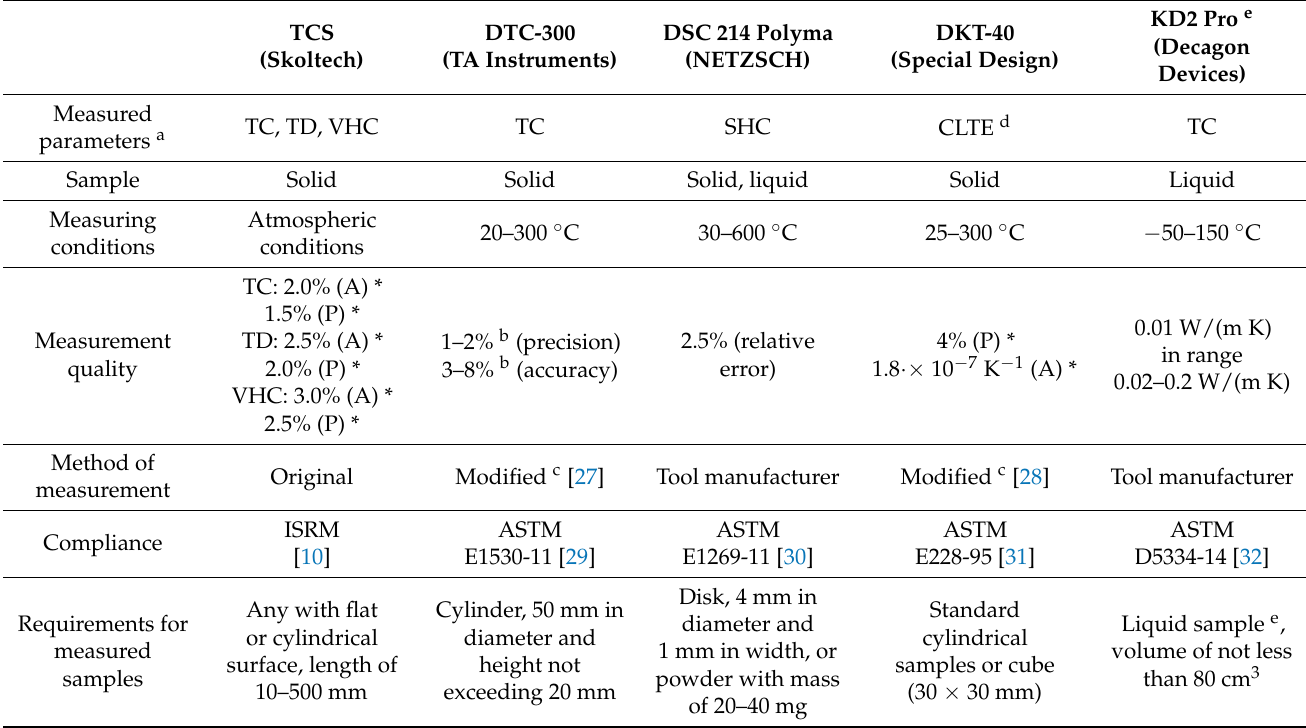
Table 1. Hardware used within the frame of this work to measure rock thermal properties and porous fluids in atmospheric conditions and within the range of formation